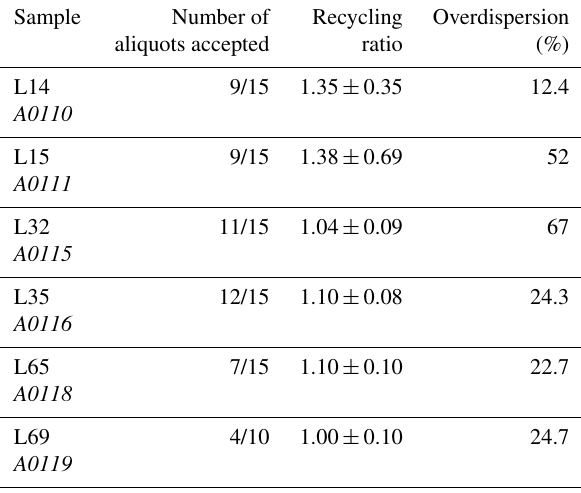
Table B1. Summary of luminescence characteristics arising from pIR-IRSL 290 protocol measurements. Sample